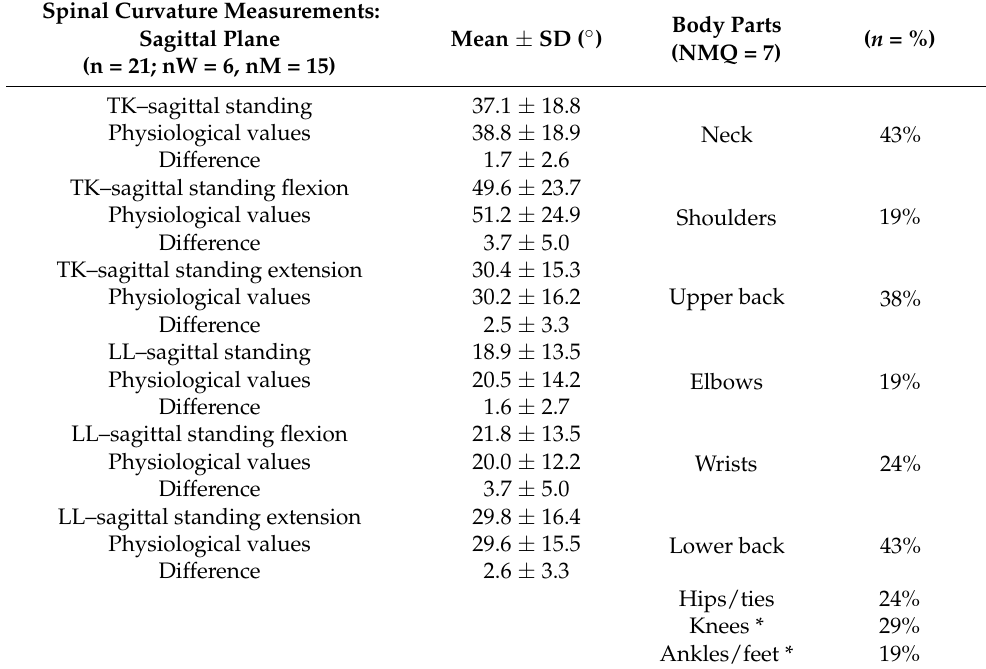
Table 2. Means and standard deviations (SD) of angles of anteroposterior spinal curvatures ( ◦ ) in three sagittal positions and the prevalence (%) and locations of musculoskeletal pain based on